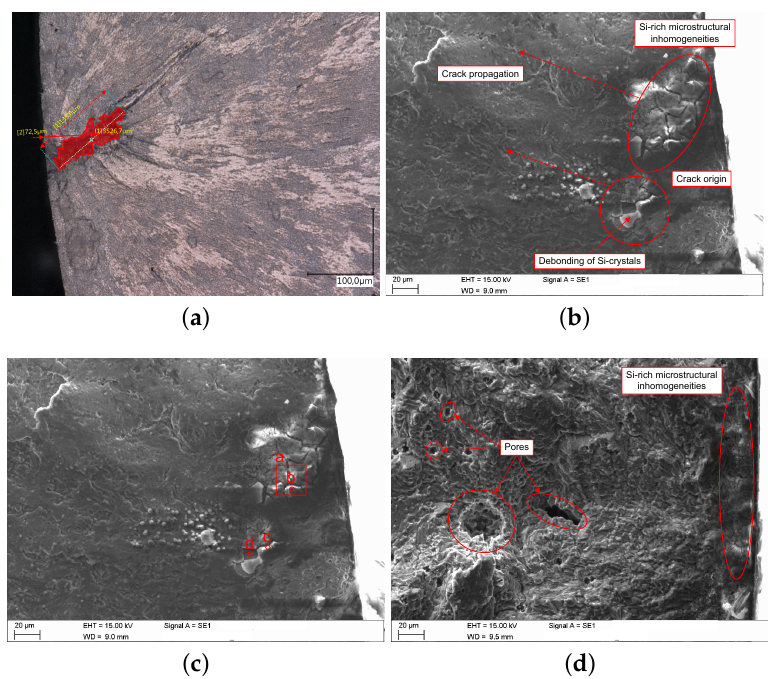
Figure 11. Fracture surface analysis of machined specimens. ( a ) Failure initiation spot of AB specimens. ( b ) Failure initiation spot of HIP specimens. ( c ) EDX analysis on the fractured surface of one HIPed specimen. ( d ) Failure initiation spot of SA specimens.